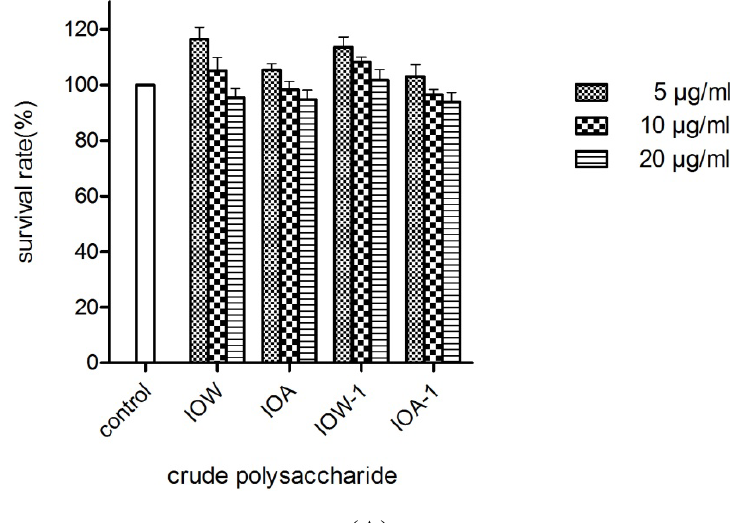
Figure 5. ( A ) Viability percentages of PC12 cells treated with crude polysaccharides; ( B ) MTT reduction assay of H on H O -induced death in PC12 2 2